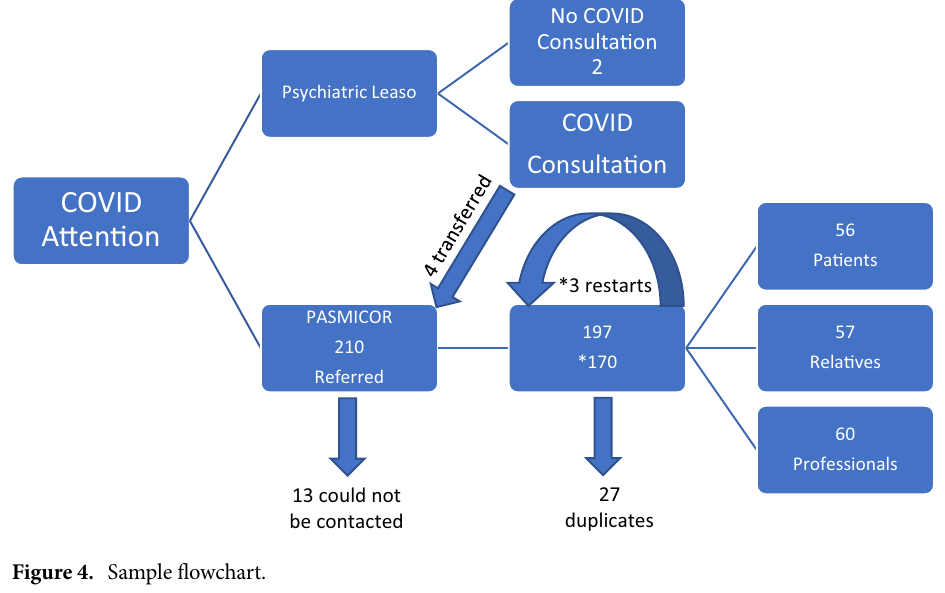
Figure 4. Sample